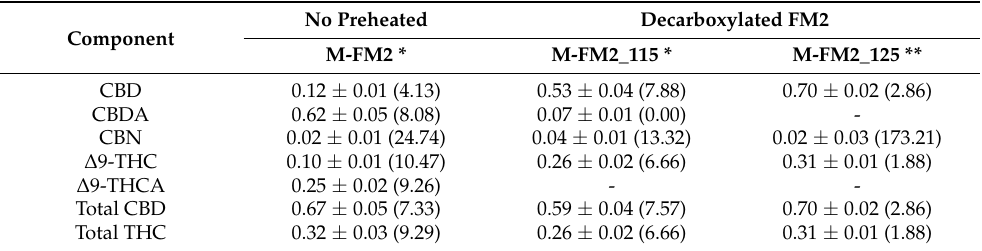
Table 3. Cannabinoids content in samples prepared using the maceration method (n = 3), expressed as % w/w (CV%): M-FM2, prepared without decarboxylation; M-FM2_115, prepared with decar- boxylated FM2 at 115 ◦ C; M-FM2_125, prepared with decarboxylated FM2 at 125 ◦ C.